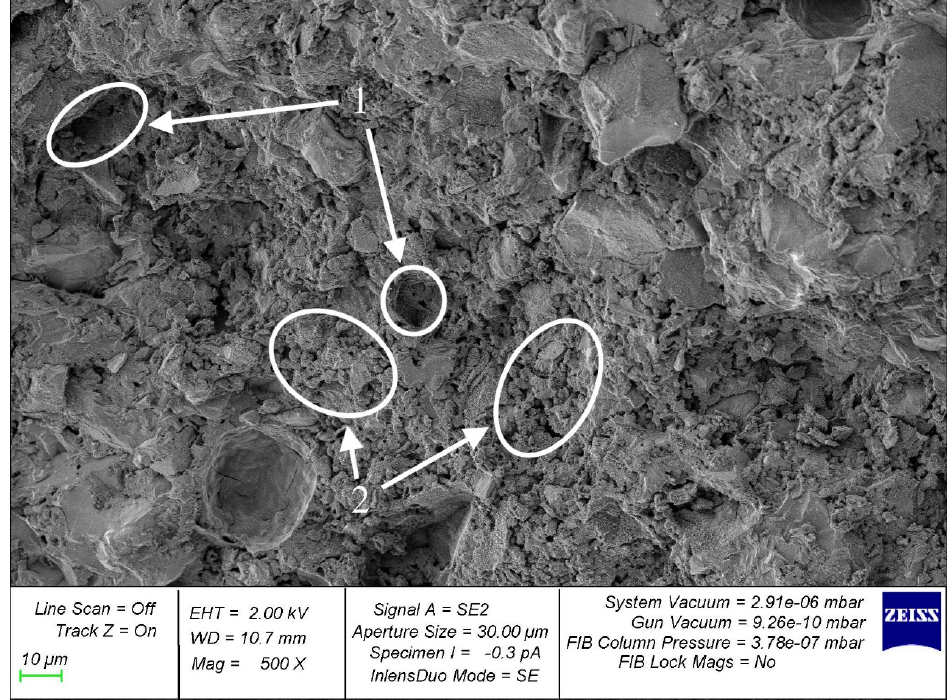
Figure 12. Sample with snail shell powder dosed at 2% (1—porosity, 2—binder phase).